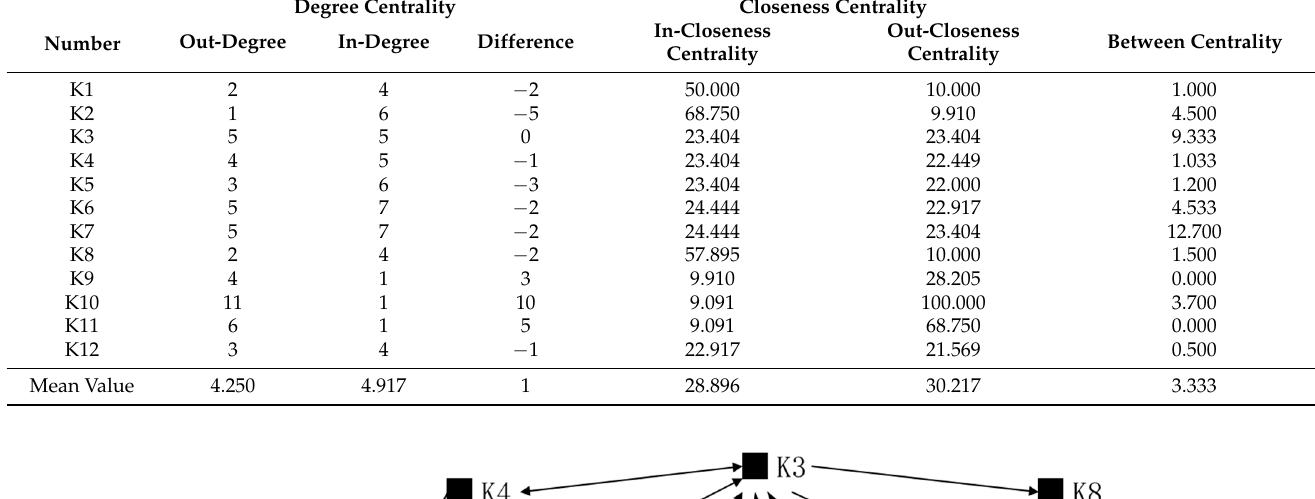
Table 8. Centrality analysis of key hindering factors of BIM applications.